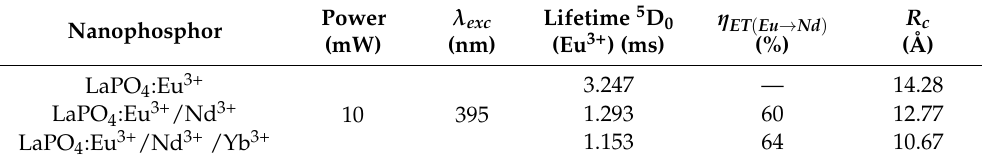
Table 1. Selected optical parameters of LaPO 4 :Eu 3+ , LaPO 4 :Eu 3+ /Nd 3+ , and LaPO 4 :Eu 3+ /Nd 3+ /Yb 3+ samples.